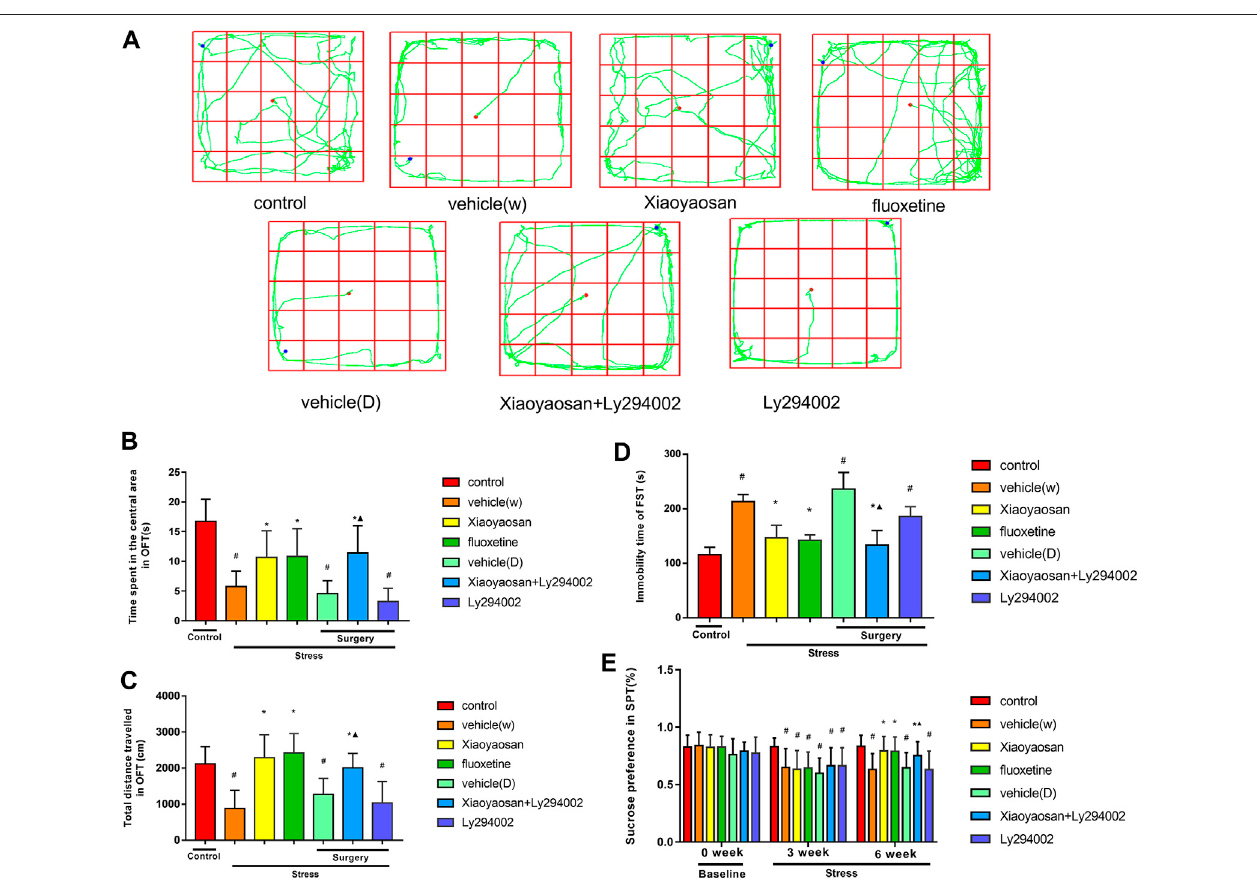
FIGURE3| XiaoyaosanamelioratesCUMSratdepression-likebehaviors (A) Movementtrajectoryofeachgroupofrats (B) TimespentinthecentralareaintheOFT by therats ineach group (C) Total distance traveled within5 minin theOFTby therats ineach group (D) Immobility time in theFST oftherats in each group (E) Sucrose preference in the SPT of the rats in each group in weeks 0, three and 6. All data are expressed as the mean ± SD. # p < 0.05 compared to the control group; * p < 0.05 compared to the vehicle (W) group; ▲ p < 0.05 compared to the Ly294002 group, n (cid:2) 18.